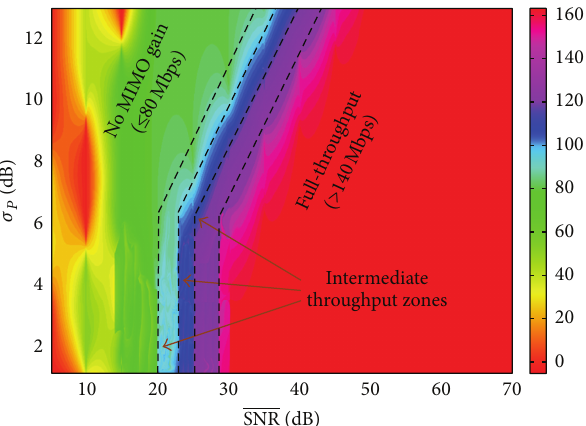
Figure 4: Downlink throughput values provided by the LTE-A link-level simulator for the 2 × 2 i-MIMO case as a function of average SNR and 𝜎 𝑃 .